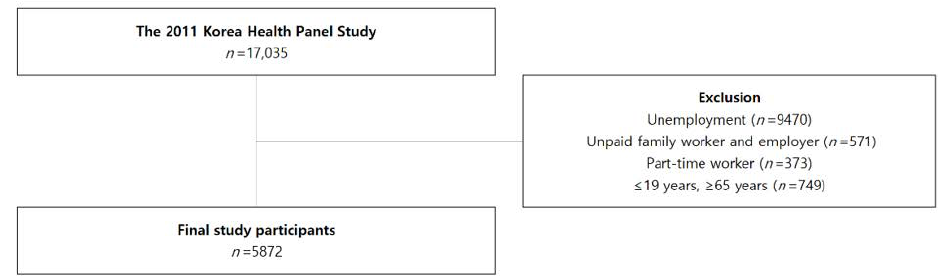
Figure 1. Schematic diagram of study